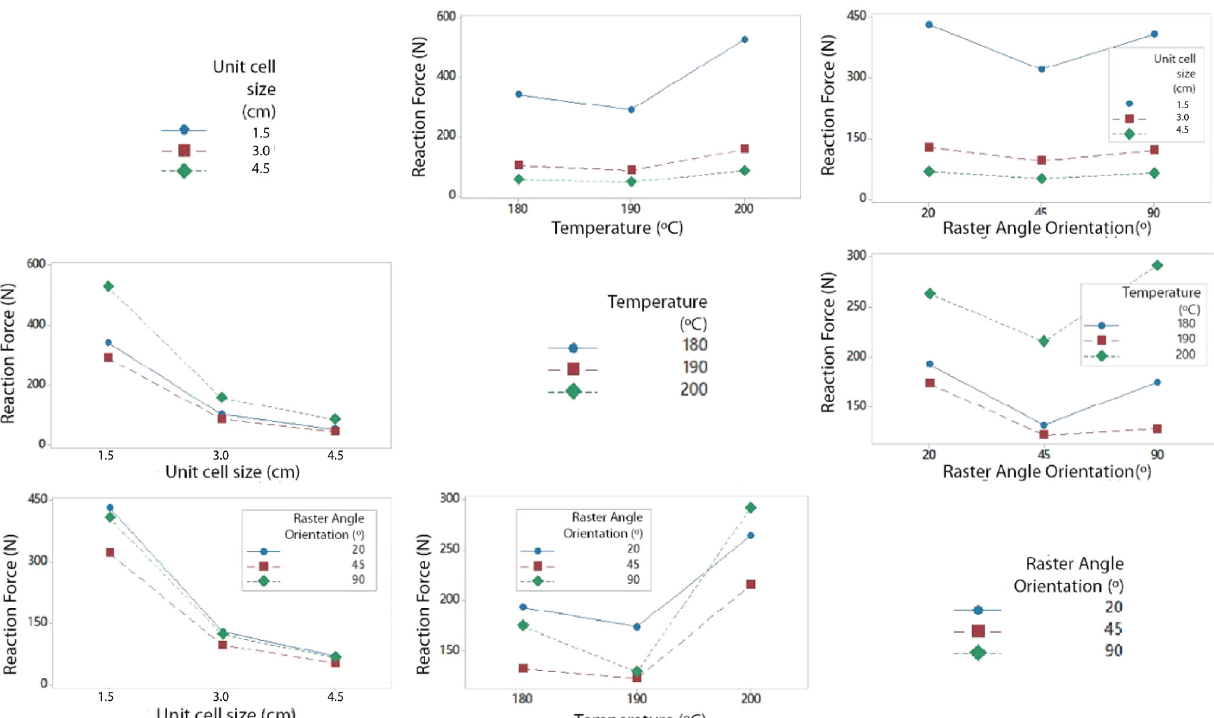
Figure B2. Interaction graph for BCCz. Figure A3. Interaction graph for